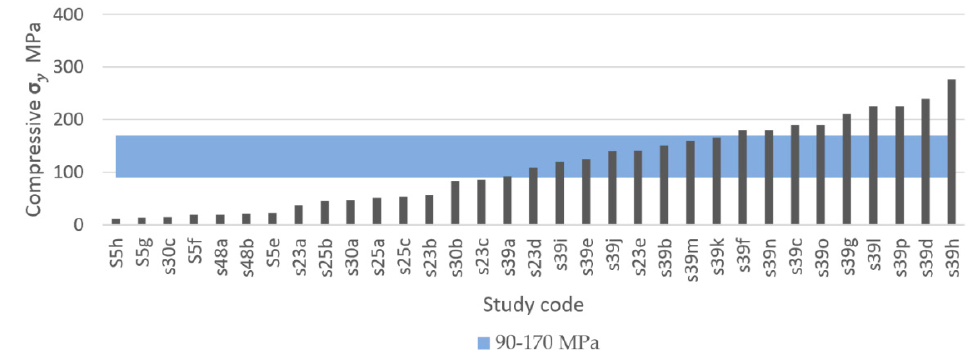
Figure 14. Compressive yield strength of porous metamaterials based on triply periodic minimal surfaces (TPMS) compared with the Ideal Quality Attribute (IQA) target zone.